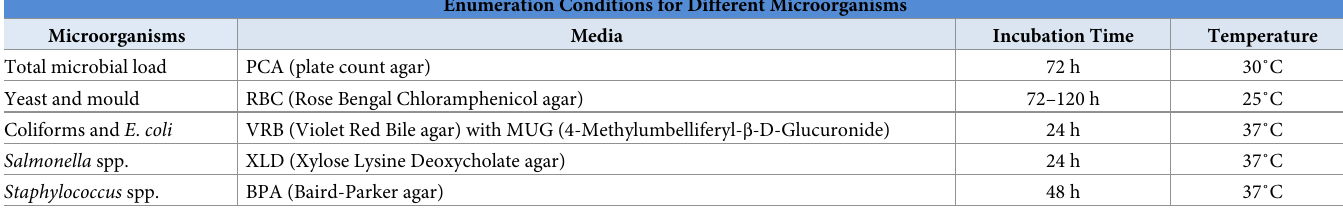
Table 1. Media, incubation time and